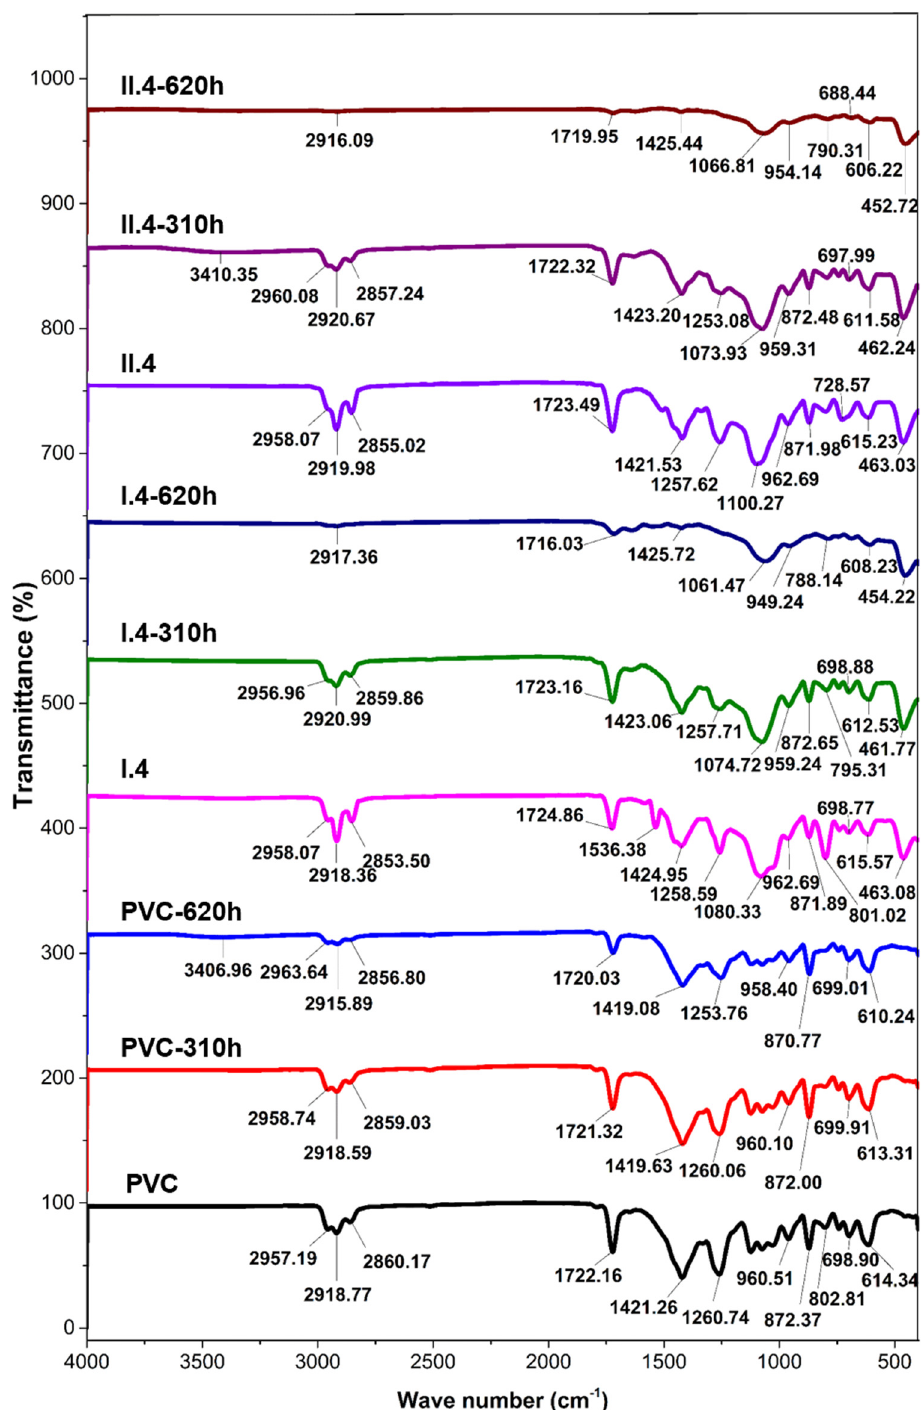
Figure 7. ATR-FTIR spectrums of PVC, I.4, and II.4 before and after aging in